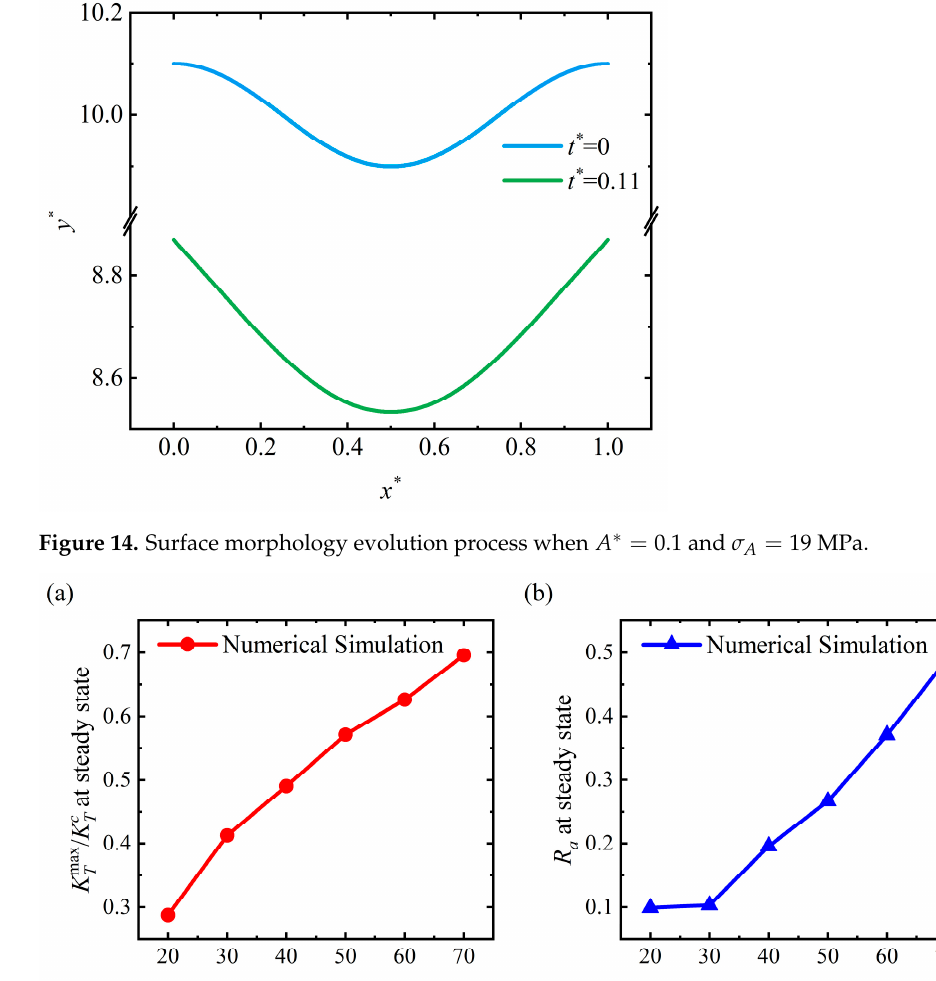
Figure 13. Evolution of ( a ) the maximal stress concentration factor and ( b ) surface roughness during corrosion when